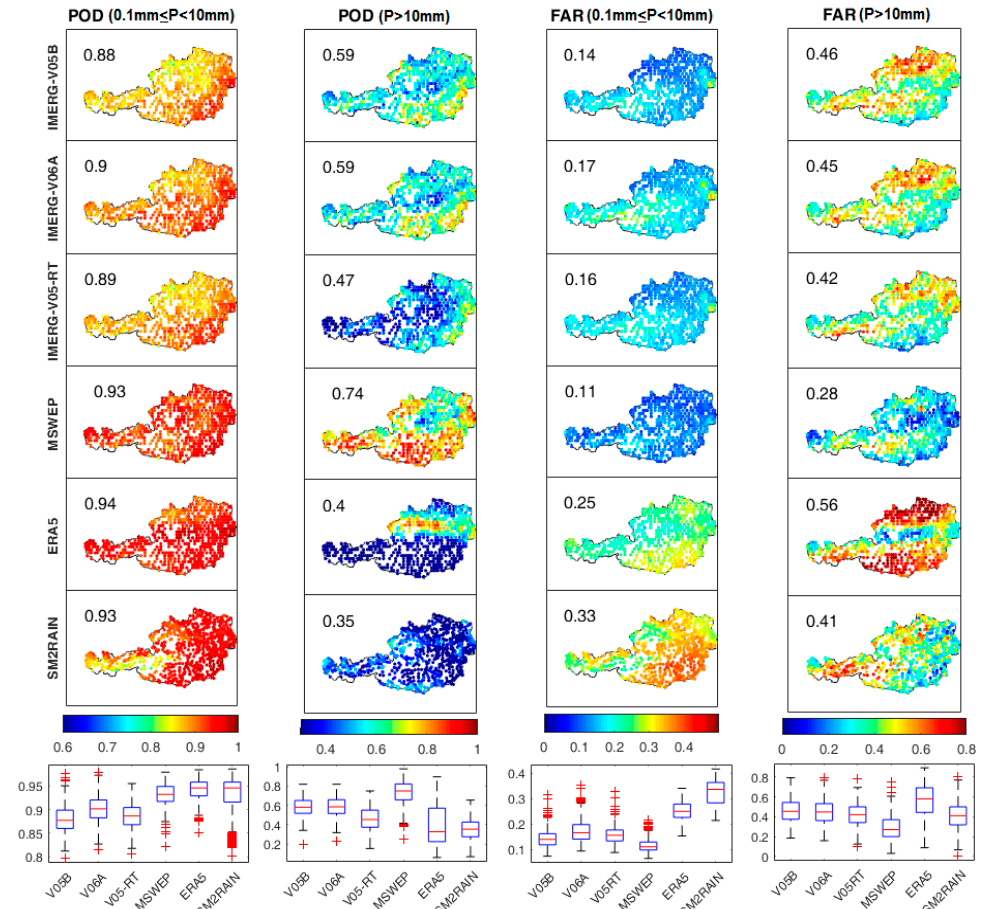
Figure 10. Spatial distributions and box-plots of POD and FAR at daily scale with respect to precipitation range of light-moderate (0.1 mm ≤ P < 10 mm) and heavy (P > 10 mm) events over Austria. The red-line in the middle of the box-plots represent the median value, the lines above and below the box represent the 25th and 75th percentile values, respectively, while the whiskers represent the extreme values.